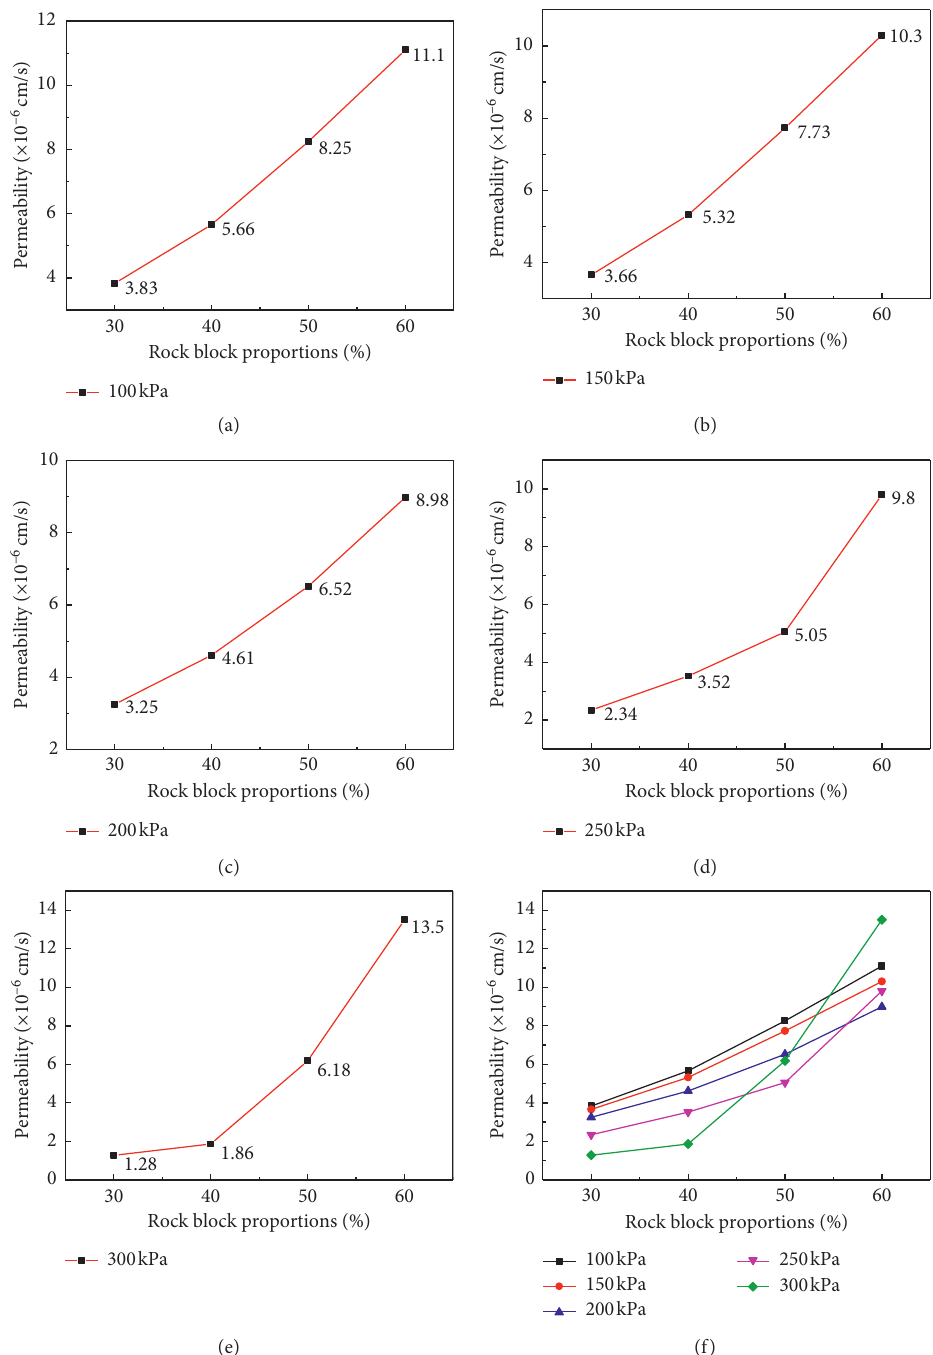
Figure 8: Variation curve of rock block proportion and permeability. (a) P � 100kPa; (b) P � 150kPa; (c) P � 200kPa; (d) P � 250kPa; (e) P � 300kPa; (f)